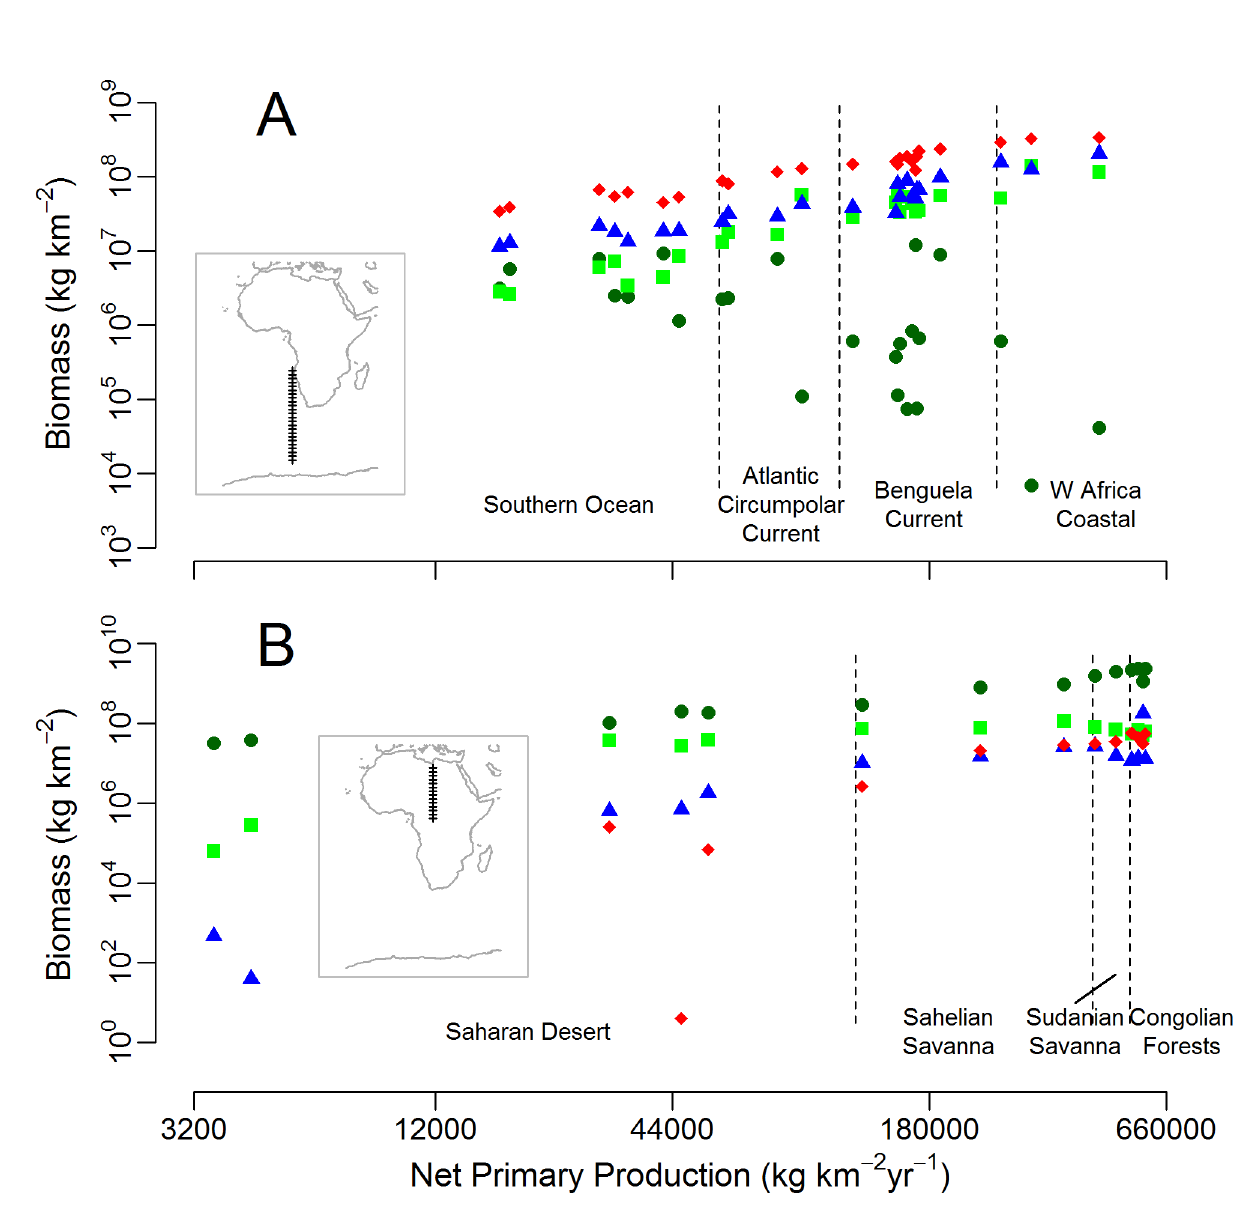
Figure 6. Ecosystem structure along productivity gradients. Variation in emergent ecosystem structure along productivity gradients in the marine environment (A) from the Southern Ocean to the West African Coast and in the terrestrial realm (B) from the Saharan Desert to the Congolian Forests. Transect locations are presented on the maps set into each panel. Dark green circles correspond to autorotroph biomass, light green squares correspond to herbivore biomass, blue triangles to omnivore biomass, and red diamonds to carnivore biomass. Broad biogeographic regions are roughly distinguished using dashed vertical lines.